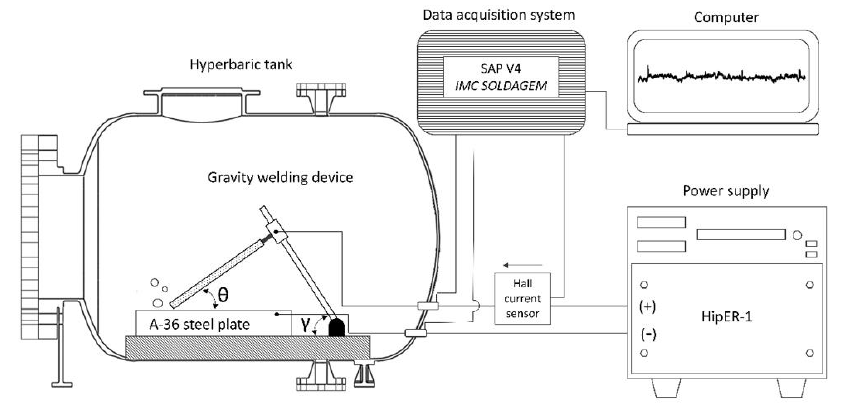
Figure 1. Diagram of the welding jig. Uribe et al. (2017) [32] defined that the angle θ is related to the welding speed and the angle γ is related to the component of gravitational force acting on the electrode fixation claw. Adapted from the work in [32].